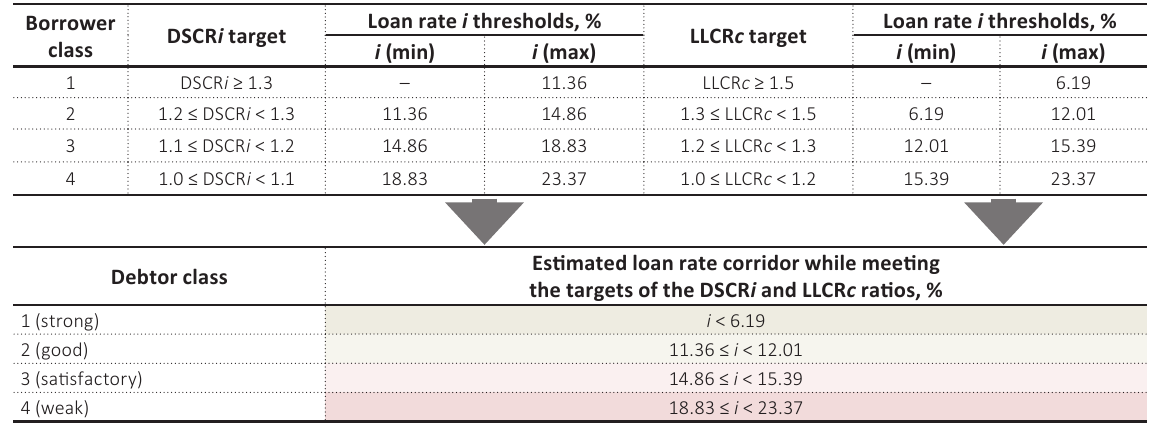
Figure 2. Determining the loan rate change corridor for an investment project adjusted for the DSCR i and LLCR с targets (to achieve target DSCR i and LLCR с